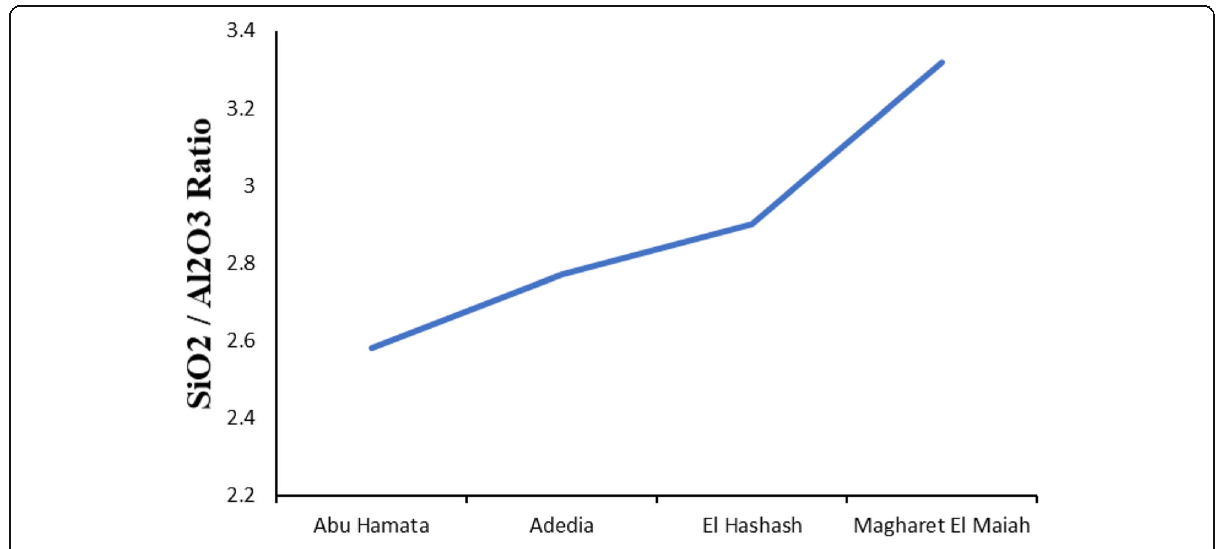
Fig. 7 SiO 2 /Al 2 O 3 ratio of the studied Paleozoic mudrocks